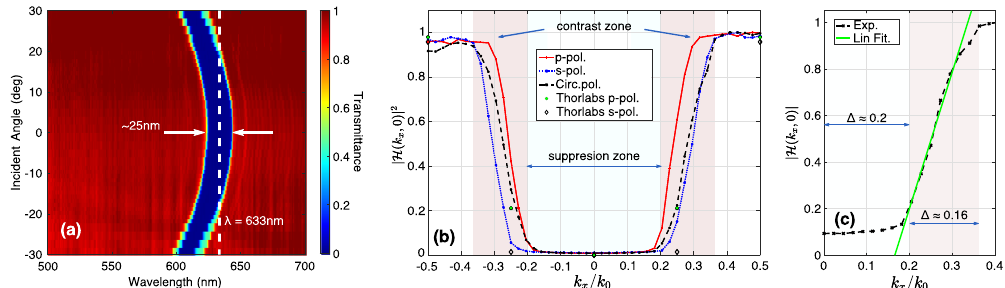
Figure 2. The experimental transmission response of the filter obtained by incrementally rotating the filter ( a ). The dashed line in ( a ) indicates the band-stop wavelength of 633 nm and the arrows indicate the width of the band-stop region at normal incidence. The modulus-square of the modulation transfer function along k y = 0 for various polarizations ( b ) is compared to data provided by the manufacturer. Linear fitting of the modulation transfer function for circular polarization in the contrast zone is given in ( c